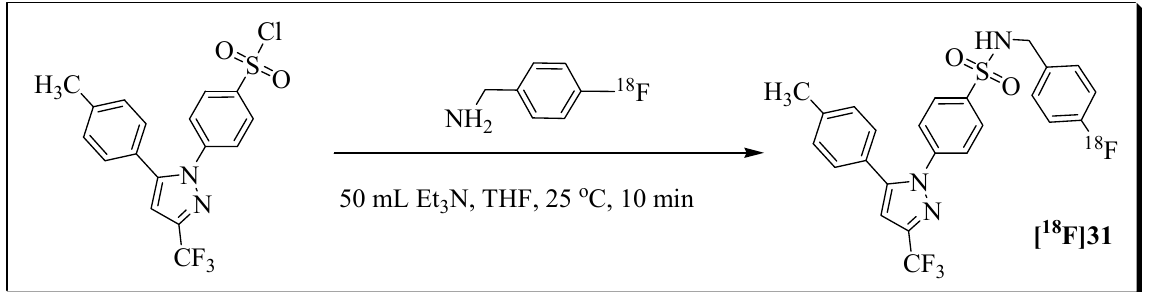
Figure 9. Radiosynthesis of radioligand [ 18 F] 31 from labelling precursor and 4-[ 18 F]fluorobenzylamine ([ 18 F]FBA).